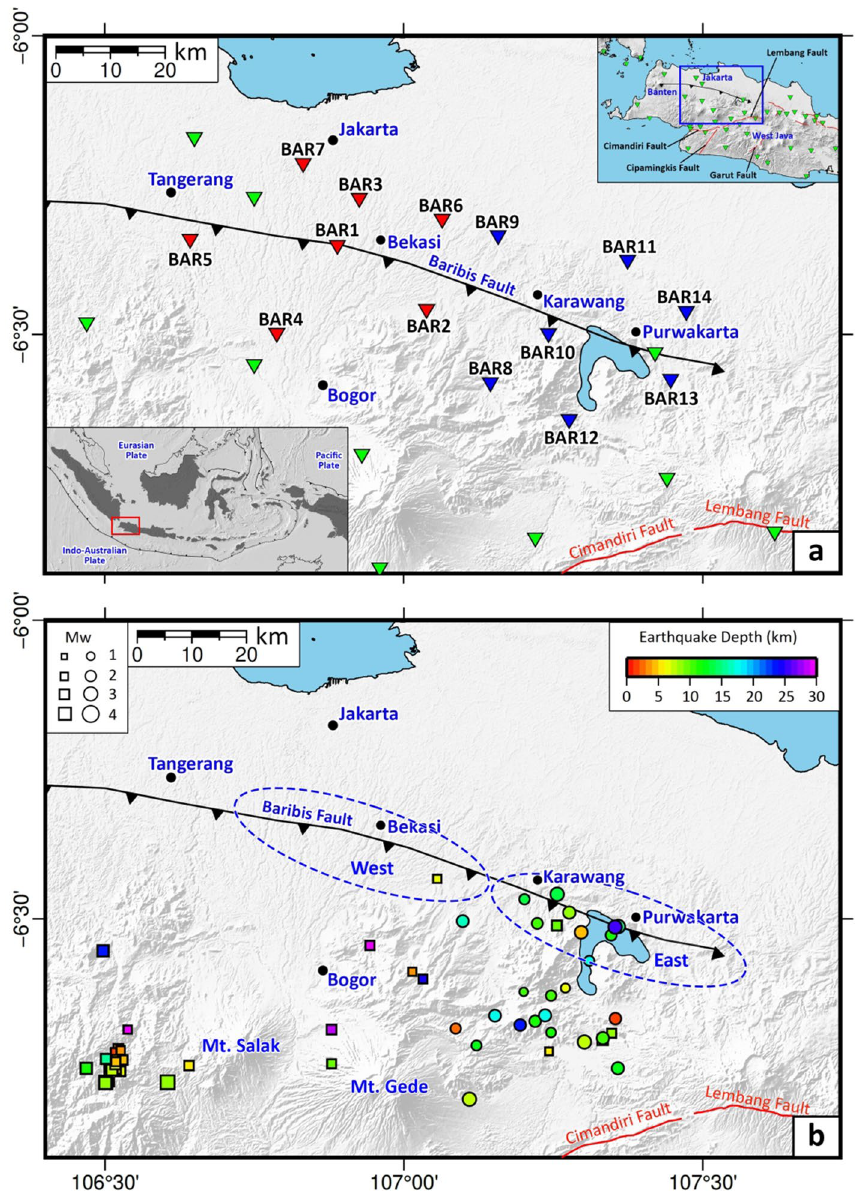
Figure 1. Regional setting and distribution of epicenters. ( a ) Map showing the location of the study area. Blue inverted triangles depict the location of borehole seismic stations used in this study. Red inverted triangles denote the borehole seismic stations used in the previous study by Damanik et al. 18 . Inverted green triangles represent Indonesian Agency of Meteorology, Climatology and Geophysics (BMKG) stations used in both studies. We moved stations BAR1-BAR7 to stations BAR8-BAR14 in September 2020. The black line with a sawtooth represents the Baribis Fault, the location of which was extracted from Simandjuntak & Barber 8 . The lower left inset shows the location of the western part of West Java (red rectangle) with respect to the Indonesian region. Upper right inset shows the location of the study area (blue rectangle) with respect to the western part of West Java. Red lines correspond to other major crustal faults including Cimandiri and Lembang Faults 3,4 , Garut Fault 13 , and Cipamingkis Fault 14 . ( b ) Map of the relocated earthquakes from July 2019 to July 2021. Events were determined and relocated using borehole and BMKG seismometers when they were recorded by both instrument types, otherwise by borehole seismometers only (see Supplementary Table 2). The colored squares and dots depict epicenters of events from July 2019 to August 2020 18 and from September 2020 to July 2021 (this study), respectively. Dashed ellipses depict the western and eastern parts of the fault discussed in this paper. The Generic Mapping Tools (GMT) version 6.0 59 (https:// www. gener ic- mappi ng- tools. org/) was used to make this